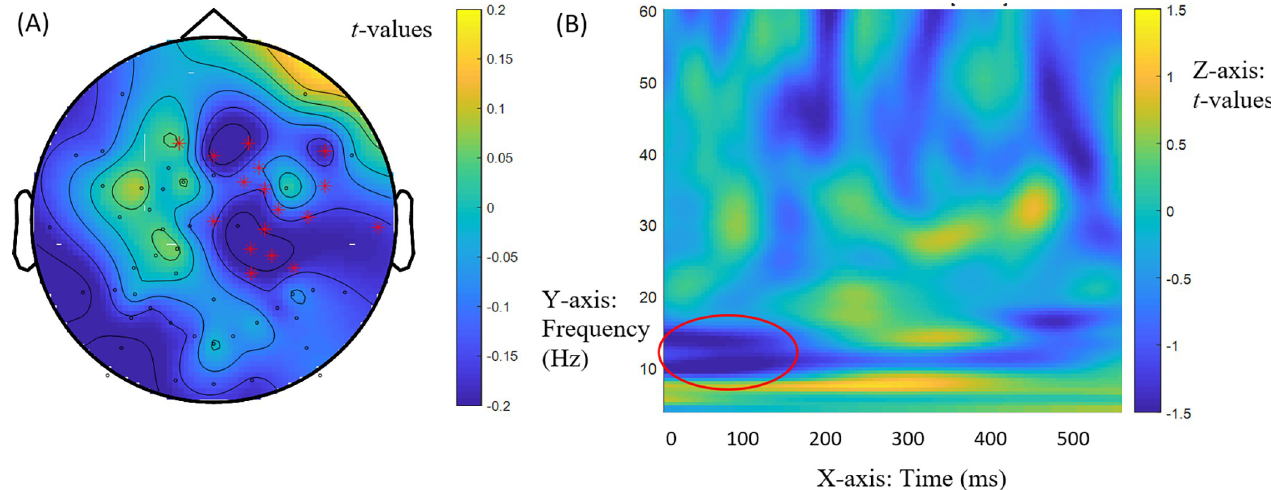
Fig 2. General effects at bridge verb dit ‘said’ at 13-14Hz (low beta band). (A) Mod-Comp differences across match and mismatch conditions [(2a)—(2b)]— [(2c)—(2d)] in induced power at bridge verb dit ‘said’ at 13-14Hz (low beta range) between 0 and 160ms across NS and NNS groups. The red marks indicate the electrodes for these effects (electrodes ‘E1’, ‘E2’, ‘E3’, ‘E4,’, ‘E5’, ‘E8’, ‘E10’, ‘E41’, ‘E49’, ‘E50’, ‘E51’, ‘E53’, ‘E55’, ‘E56’, E57’, ‘E58’, ‘E60’). (B) Time (x axis) frequency (y axis) plot of Mod-Comp differences in induced power (z axis). The circled area shows the effects.